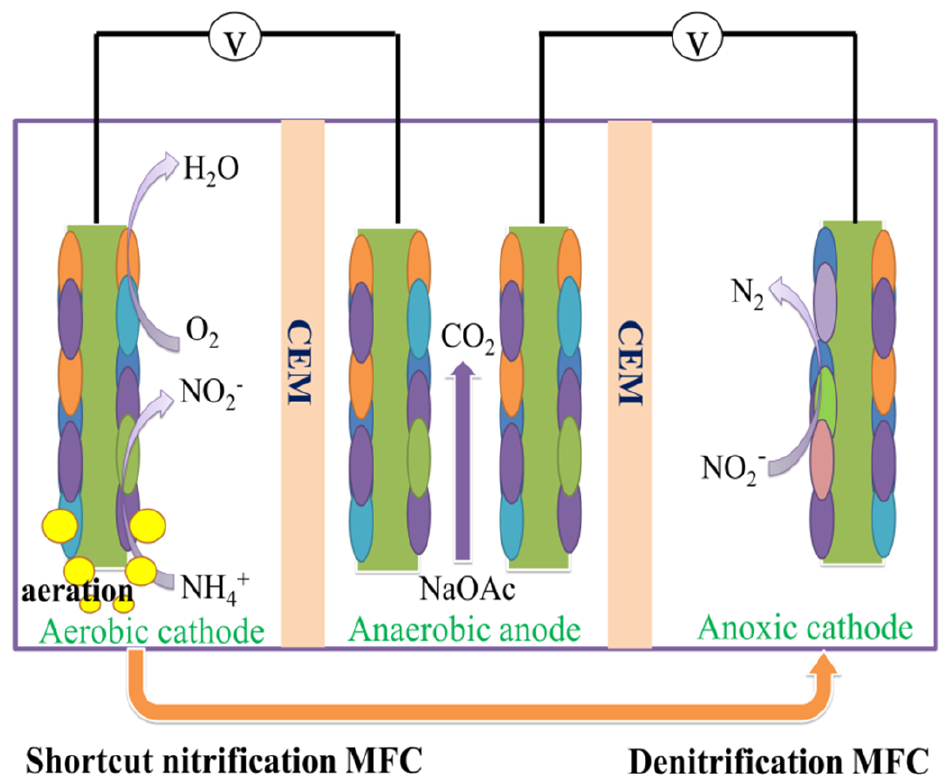
Figure 3. Schematic of the three-chamber MFC to carry out the shortcut nitrification and denitrification process for nitrogen removal. Modified from [48].